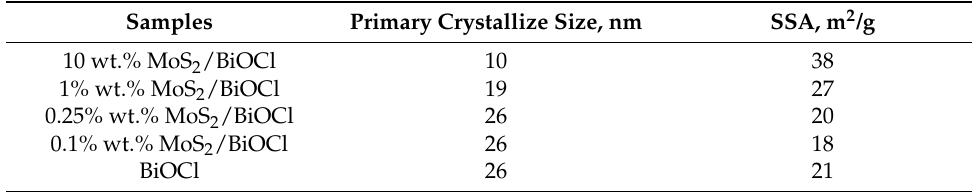
Figure 1. ( A ) X-ray diffraction patterns obtained for pure BiOCl and MoS 2 /BiOCl photocatalysts. ( B ) Zeta potential of 0.25 wt.% MoS 2 /BiOCl as a function of pH. Table 1. Characterization of the synthesized